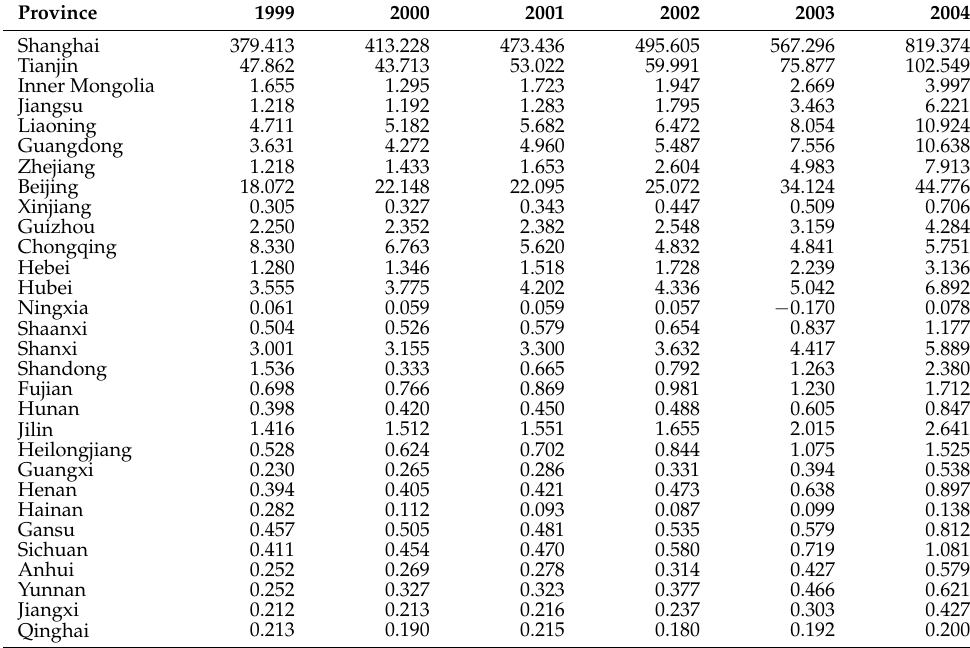
Table A4. The intra-provincial carbon inequality estimation results of original carbon emission data based on a 3-year rolling window for 30 provinces in China from 1999 to